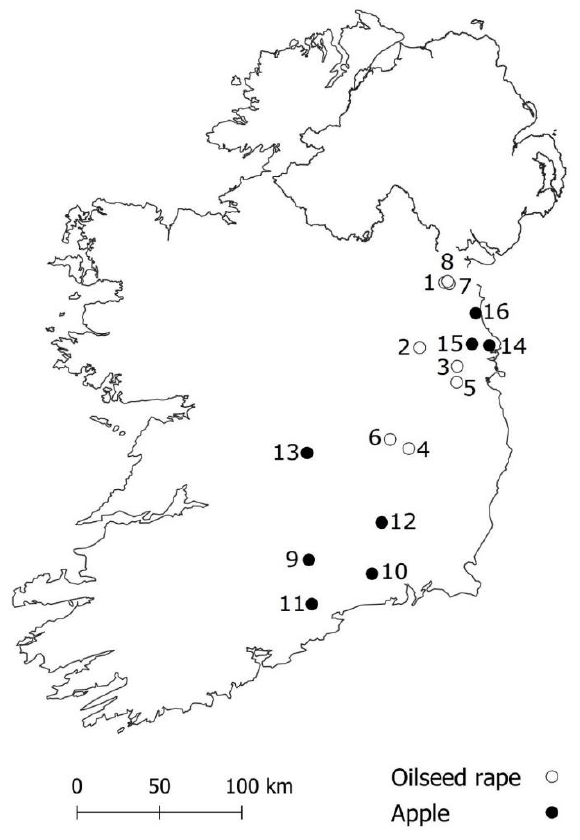
Figure 1. Locations of 16 field sites used to evaluate the use of trap nests by stem nesting Hymenoptera in the spring/summer of 2019. Closed circles represent apple orchards, and open circles oil seed rape